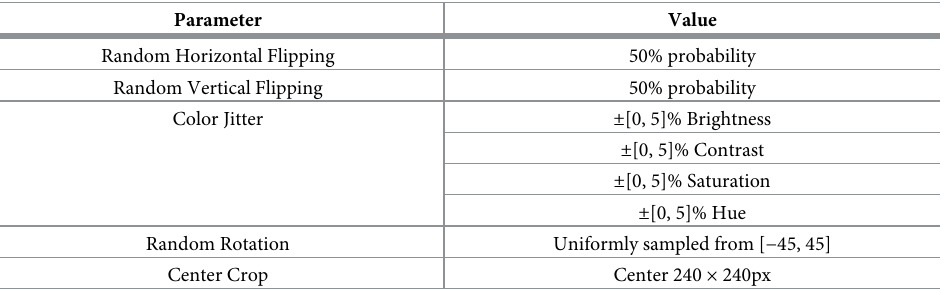
Table 1. Data augmentation and pre-processing parameters (see Torchvision [31] for implementation